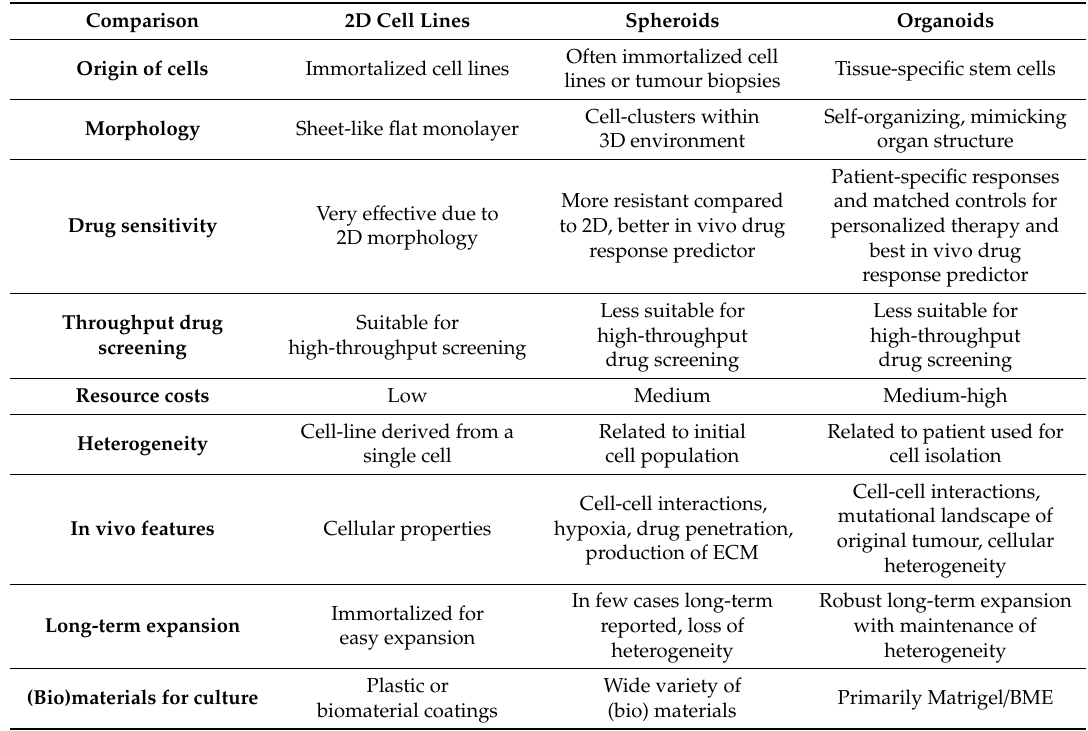
Table 1. Key di ff erences when comparing cellular characteristics and applications in two-dimensional (2D) cell lines, three-dimensional spheroids and